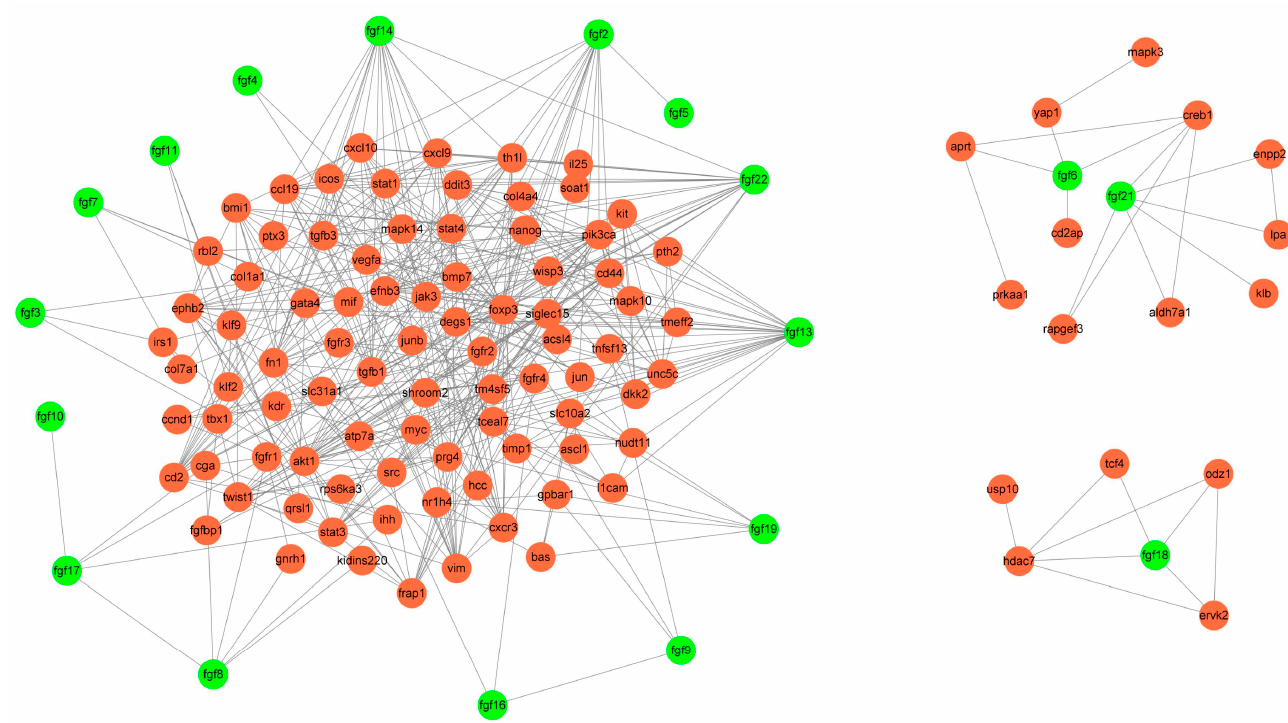
Figure 10. Interactive network mining of FGF genes.